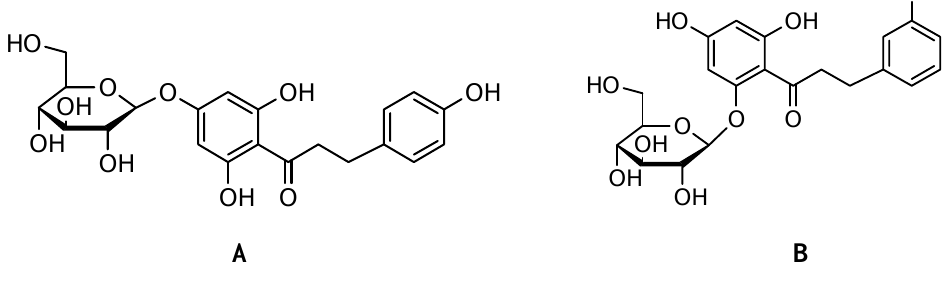
Figure 2 . Chemical structures of phloretin-4-D-glucosid ( A ) and 3-hydroxy phlorhizin glucoside ( B